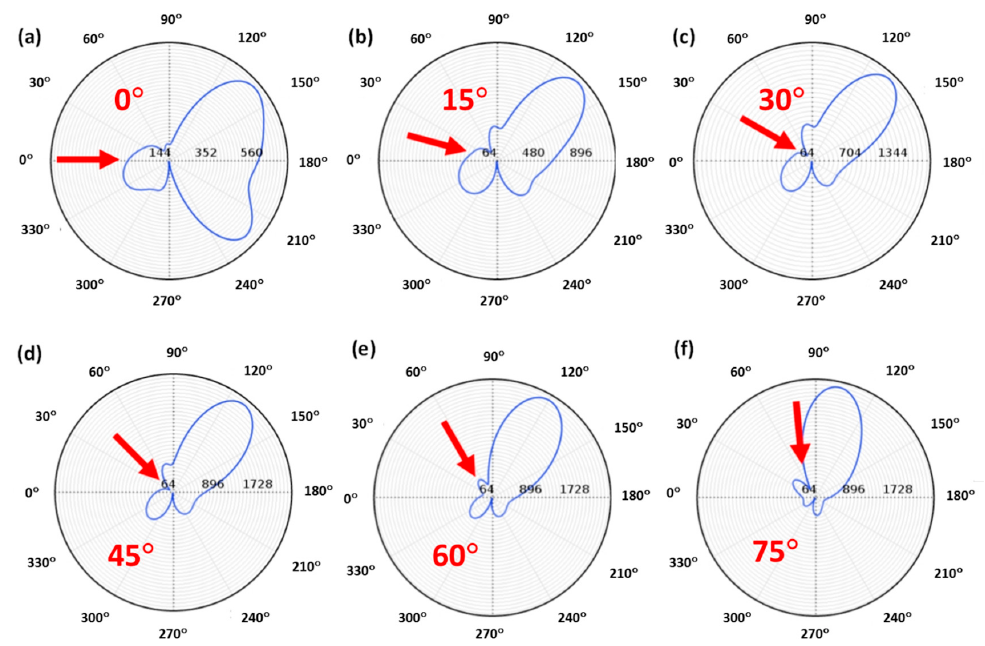
Figure 6. ( a )–( f ) Far field polar plots of a 184 nm Cu 2 O particle, satisfying the zero-backward scattering condition, on the silicon substrate for different incidence angles. The considered wavelength was 632 nm. Red arrows indicate the direction of the impinging